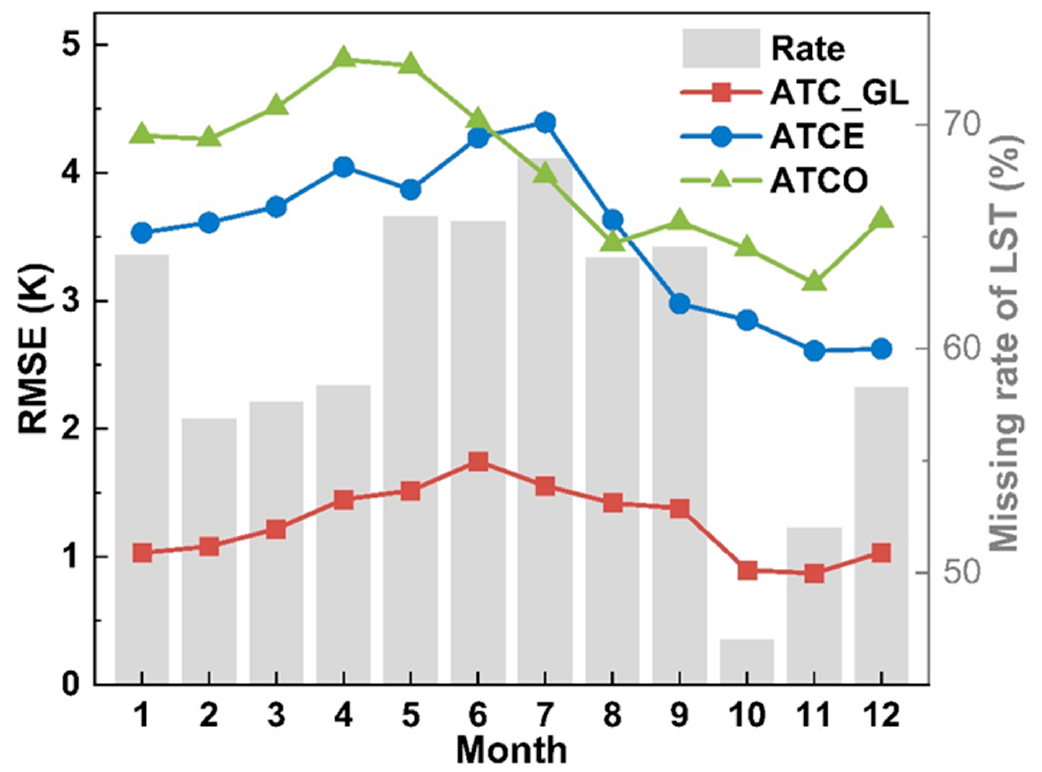
Figure 7. Monthly RMSEs of the ATC_GL, ATCE, and ATCO. The histogram represents the monthly missing rates of LST.